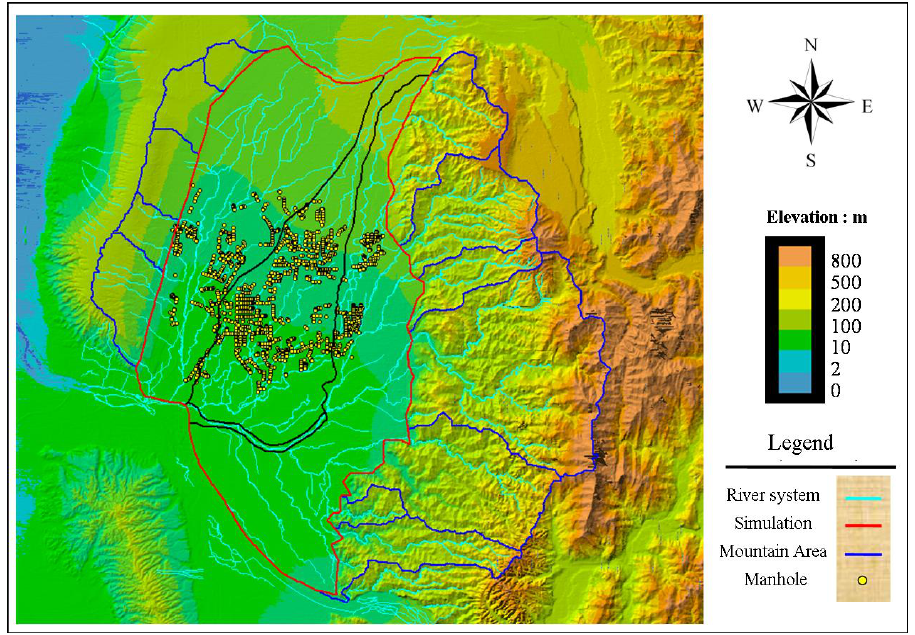
Figure 17. Distribution of the sewer manholes of Taichung